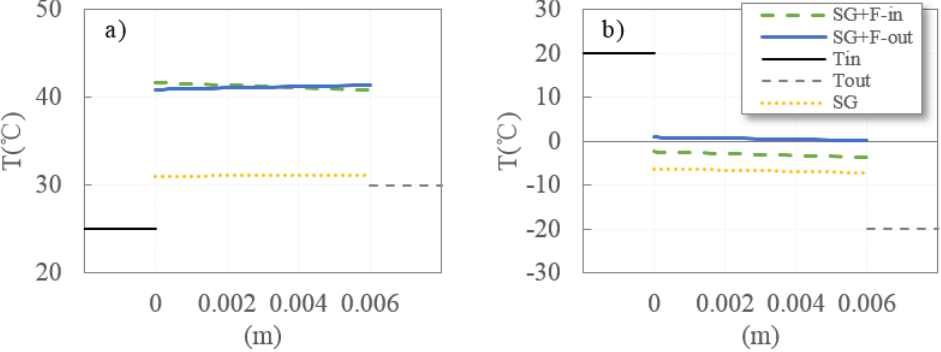
Figure 3. Temperature distribution of SG+F under typical conditions: ( a ) in summer; ( b ) in winter.